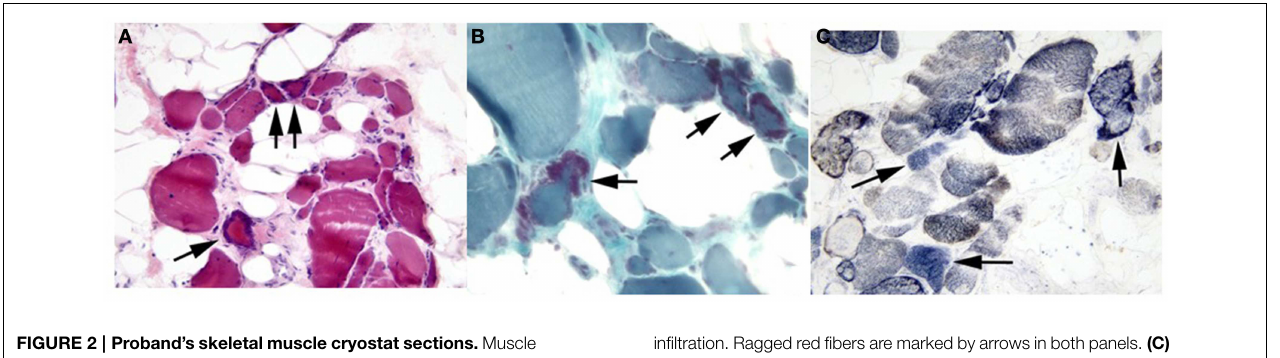
infiltration. Ragged red fibers are marked by arrows in both panels. (C) SDH/COX staining demonstrated several fibers (arrow) with SDH activity (blue) that lack COX activity (brown). Original magnifications: (A) , 200X; (B,C) ,